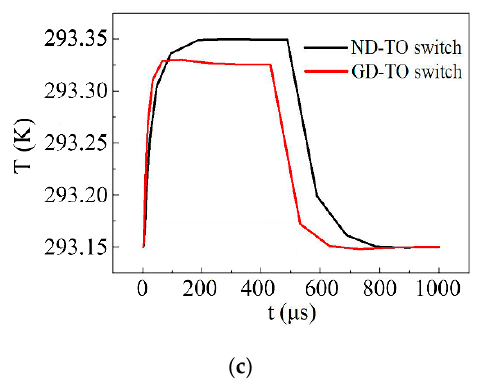
Figure 4. ( a ) and ( b ) thermal field distributions; and ( c ) calculated response times for the graphene doped (GD)-TO switch ( Rise time = 30 μ s; Fall time = 110 μ s), and non-doped graphene (ND)-TO switch ( Rise time = 78 μ s; Fall time = 164 μ s).